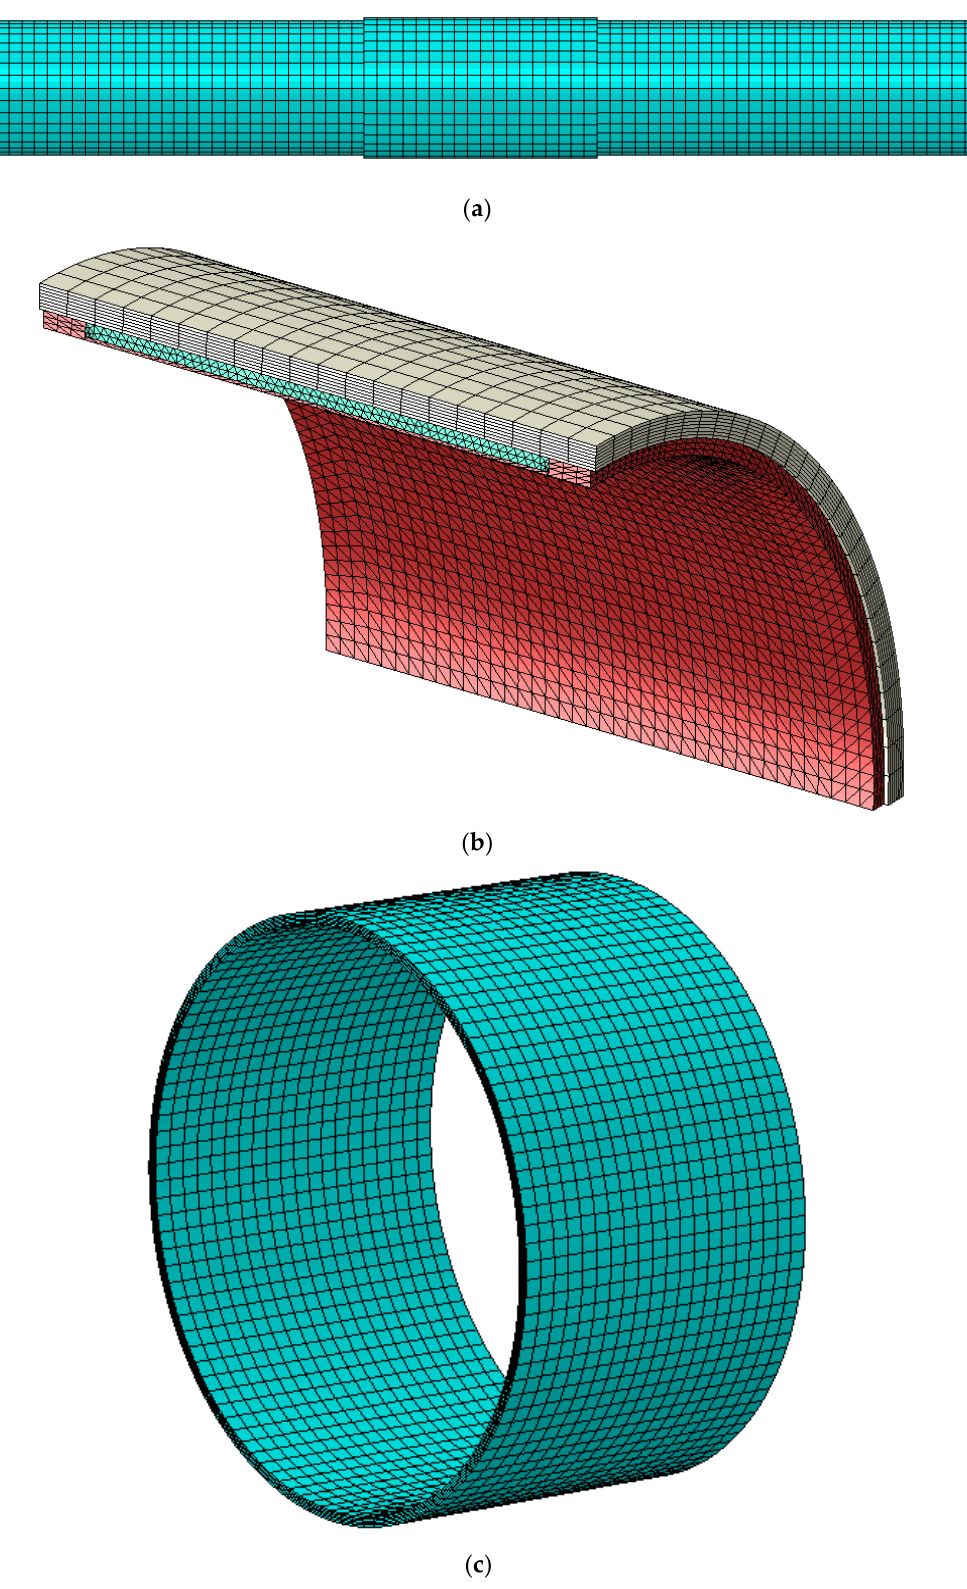
Figure 6. Submodelled positions of the global CAD model.